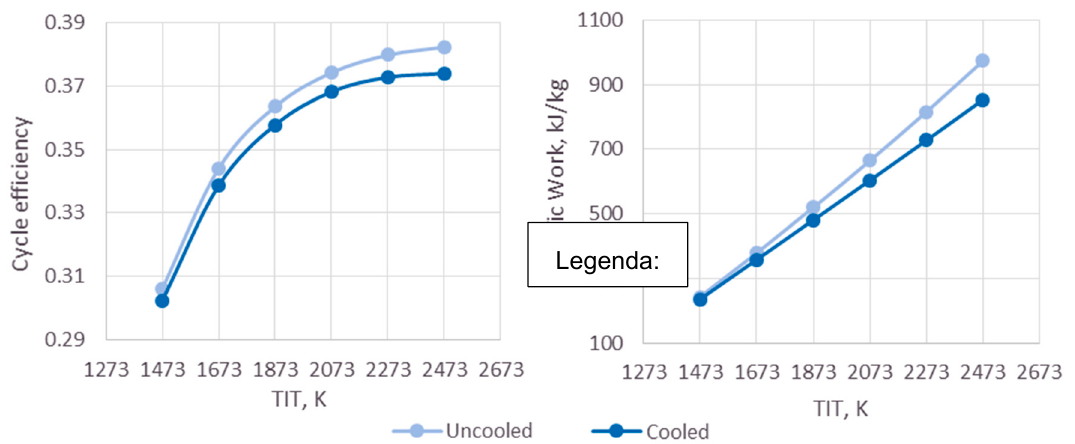
Figure 5. Cycle e ffi ciency and specific work output as a function of turbine inlet temperatures (TIT) (PR = 30).